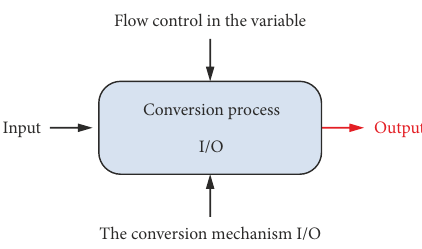
Figure 1. ICOM components of the structure of the activities of an urban transport services